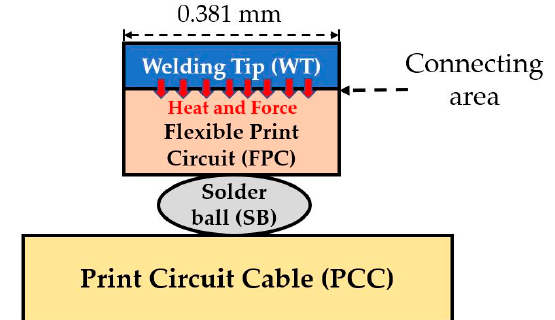
Figure 2. The RSP mechanism.